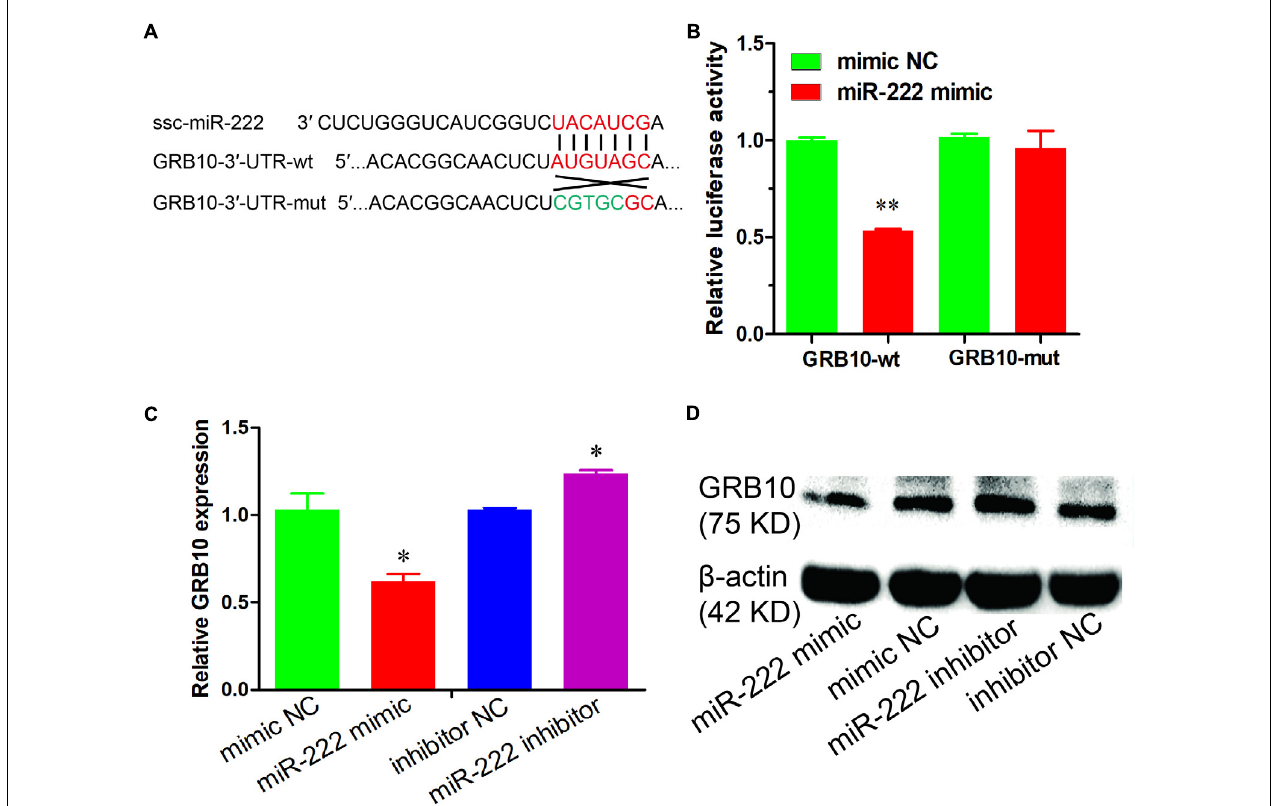
FIGURE 3 | miR-222 directly targets the GRB10 gene. (A) The target site of miR-222 and GRB10 gene was predicted using the TargetScan and RNAhybrid online software. (B) Luciferase reporter assay results were measured in immature porcine Sertoli cells with co-transfection of the miR-222 mimic/mimic NC and GRB10 -3 (cid:48) -UTR-wt/mut vector ( n = 3). Renilla luciferase (Promega) activity was used as an internal control. (C,D) The GRB10 mRNA and protein expressions were detected using qRT-PCR (C) and western blot (D) assays, respectively. pig-TBP and β -actin were used as internal controls, respectively. Data are presented as mean ± SD. ∗ P < 0.05 and ∗∗ P <